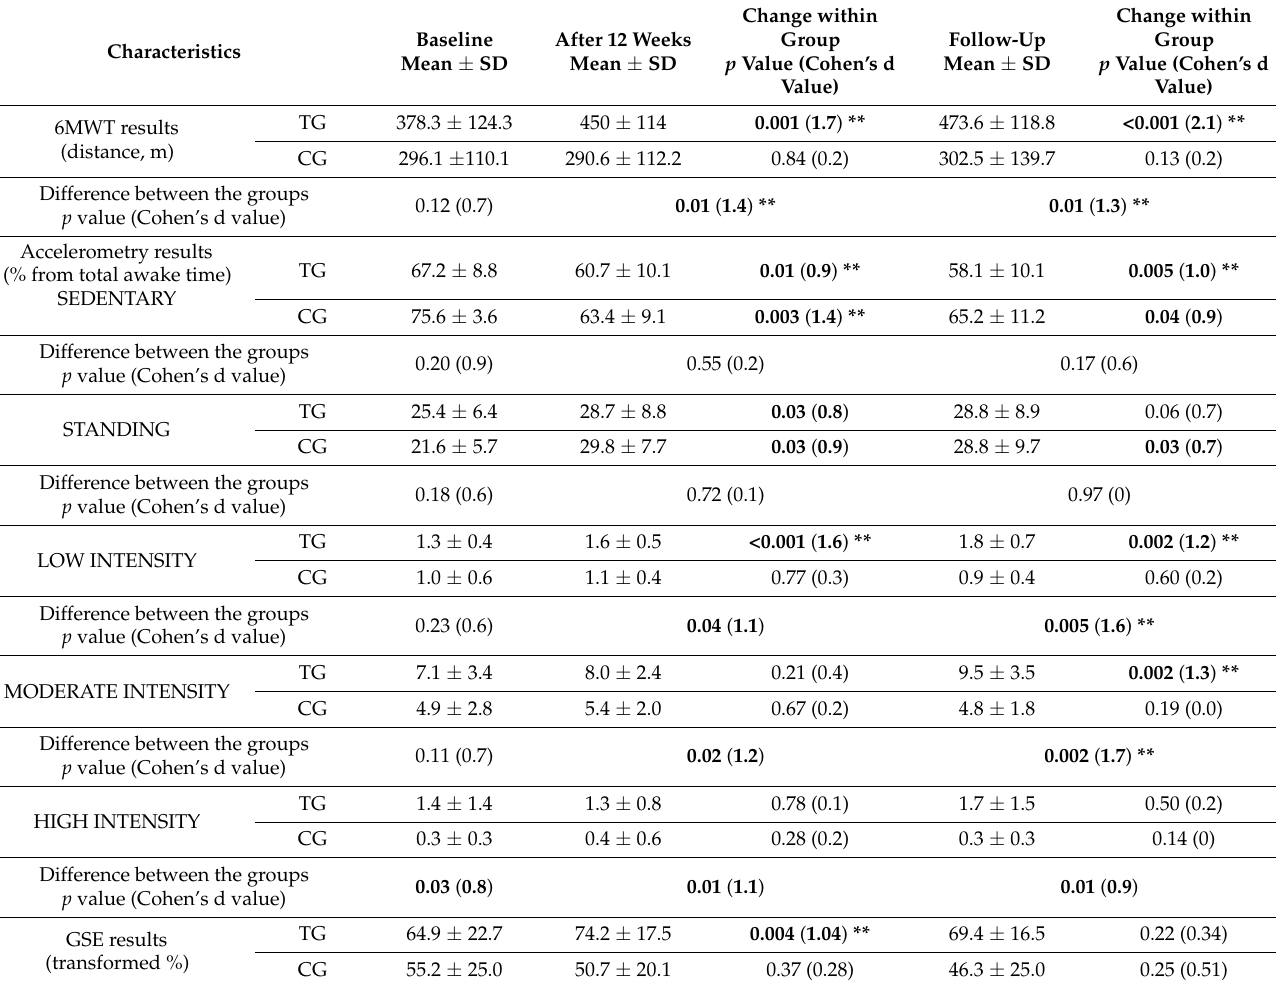
Table 2. Effects of physiotherapy program on exercise capacity, daily physical activity level, perceived self-efficacy, participation and